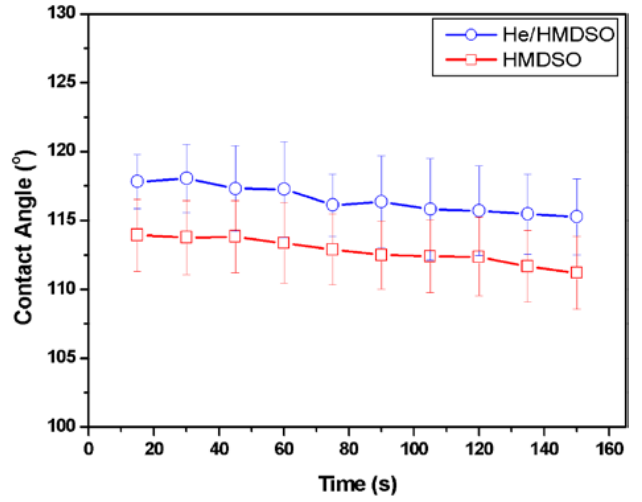
Figure 1. Time evolution of the water contact angle of TPS films after plasma treatments.